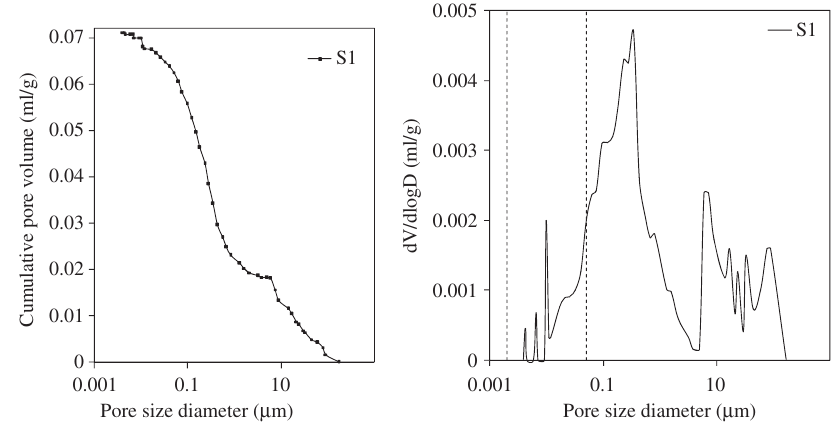
Figure 3 Pore-size distribution of silt measured by